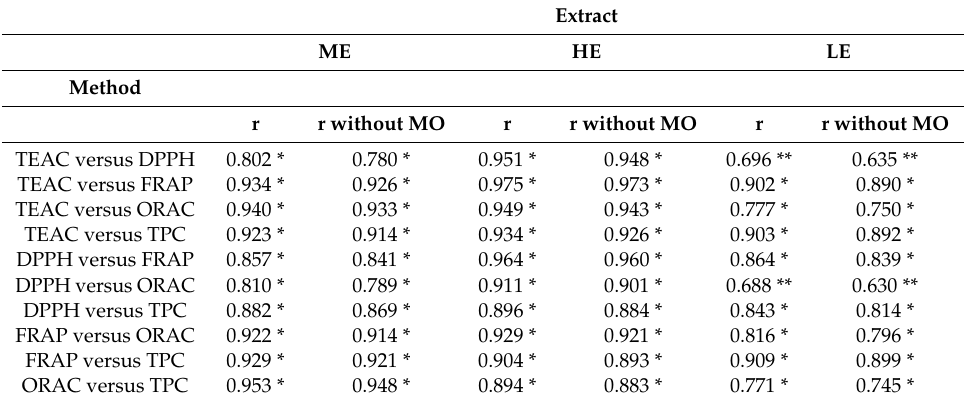
Table 5. Correlations between values obtained by di ff erent methods of analysis in similar extraction procedures with, and without, MO (* p < 0.001; ** p < 0.01).